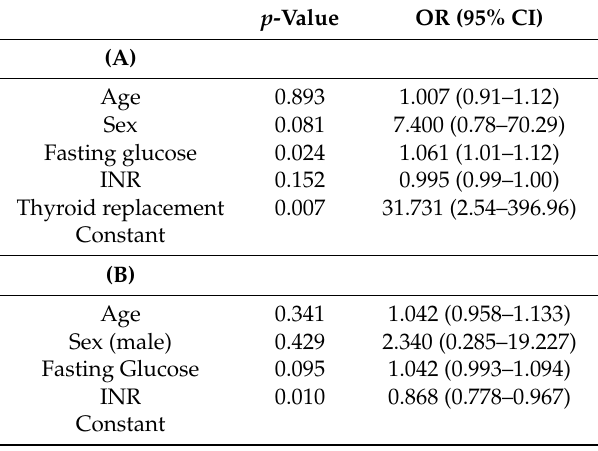
Table 4. Multivariate regression model of parameters significantly related to NASH (4A) and excluding thyroid hormone replacement which may carry a sex bias (4B).